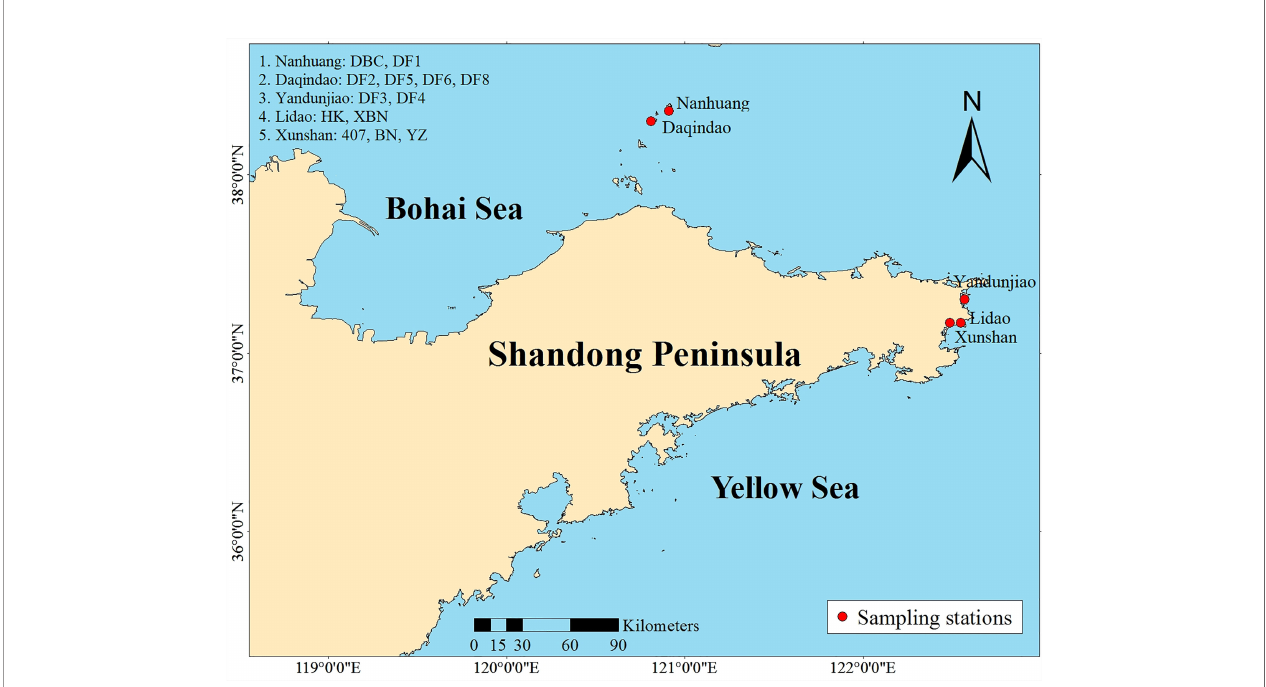
FIGURE 1 | Location of the Saccharina cultivars around the Shandong